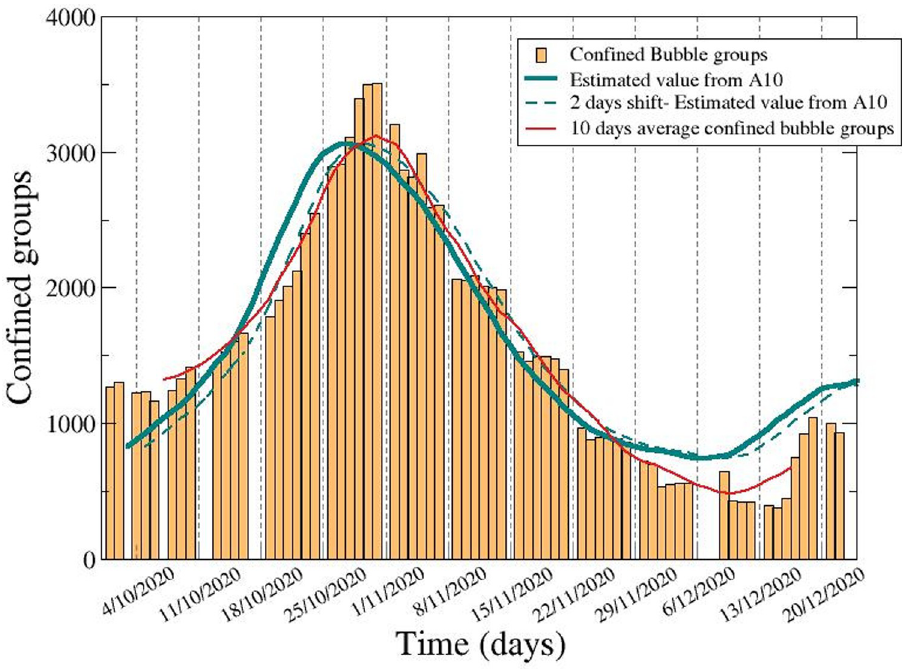
Fig 3. Evolution of the number of confined groups in schools in Catalonia compared with the estimations based on the incidence. Temporal evolution of the confined groups in Catalonia from 1 st October to 31 st December 2020 and the corresponding 7-days moving average (red solid line). Comparison with the estimations proportional to the 7-days moving average of the 10-day cumulative incidence in Catalonia using (1- η ) = 0.35 (A10, green solid line), and with the same curve with a 2-day shift (green dashed line) to highlight the delay between the A10 and the actual dynamics of the number of confined groups.